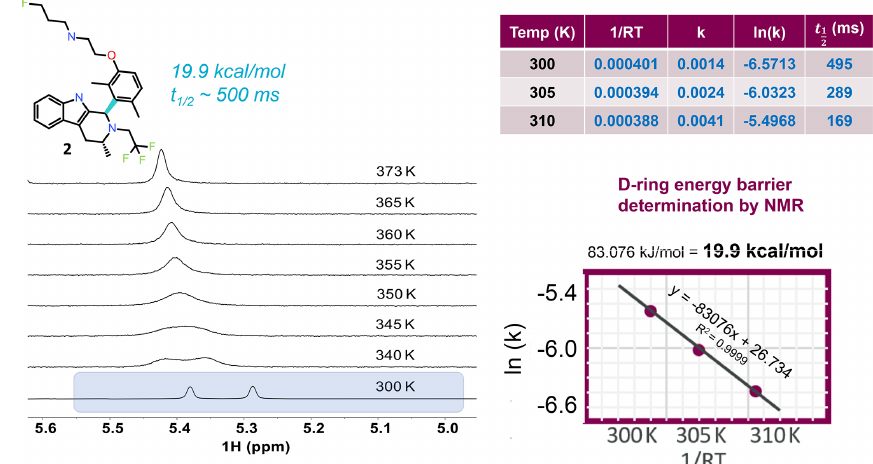
Figure 4. VT NMR stacked plots for the dimethyl compound undergoing slow to fast exchange with increasing temperature. To measure the energy barrier to rotation of the D ring, three temperatures and a 1D selective EXSY at different mixing times were used to estimate the exchange rates and half-life. An Arrhenius plot gives the barrier to rotation at 19.9kcalmol − 1 , and the 300K half-life is ∼ 0.5s.